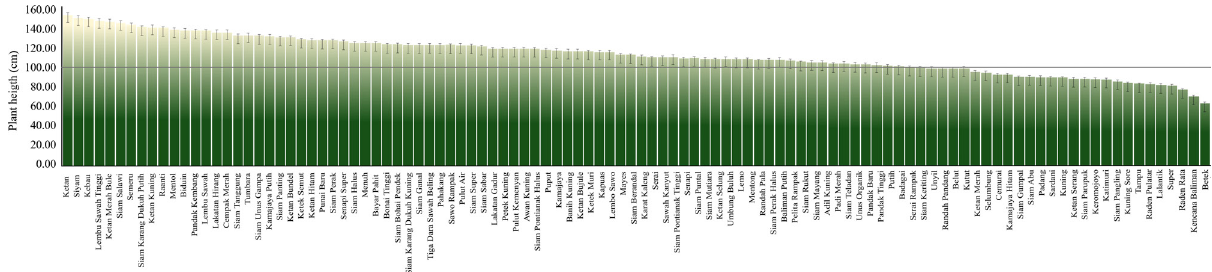
Figure 6. Plant height variation (cm) of Indonesian swamp rice germplasm growing at the ISARI Research Station, South Kalimantan,